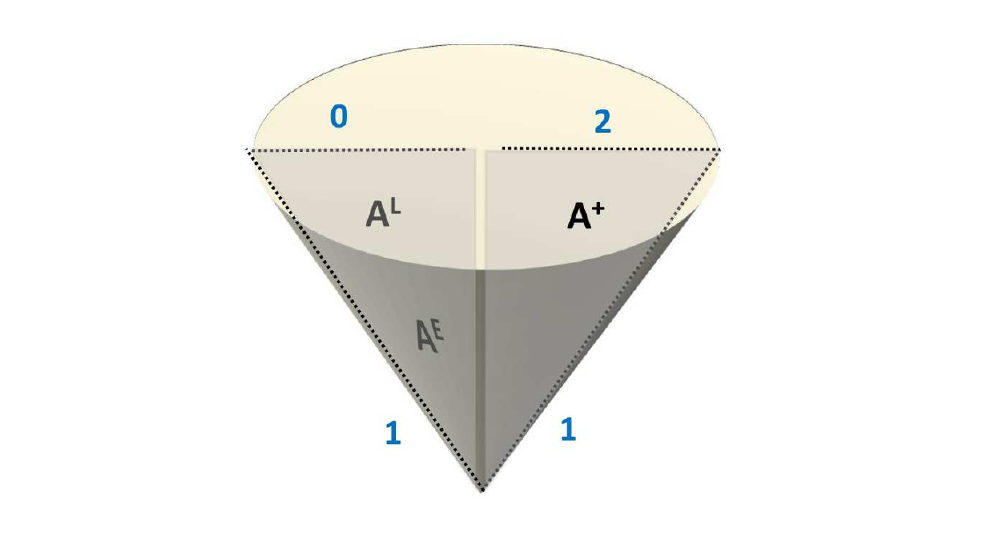
Figure 4 . The fundamental domain for the BC 2 Calogero-Sutherland model in x − 1 -space. The shaded areas in the radial direction are the Weyl chamber A + 2 and the shifted domain A L 2 . On the boundary of the cone, A + 2 is bounded by the walls ω 1 and ω 2 while A L 2 is bounded by ω 1 and ω 0 . The subset A E 2 is mapped to half of the